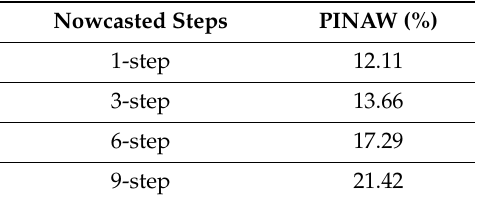
Table 2. Prediction interval normalized average width (PINAW) for proposed model at di ff erent time steps (each step is 10